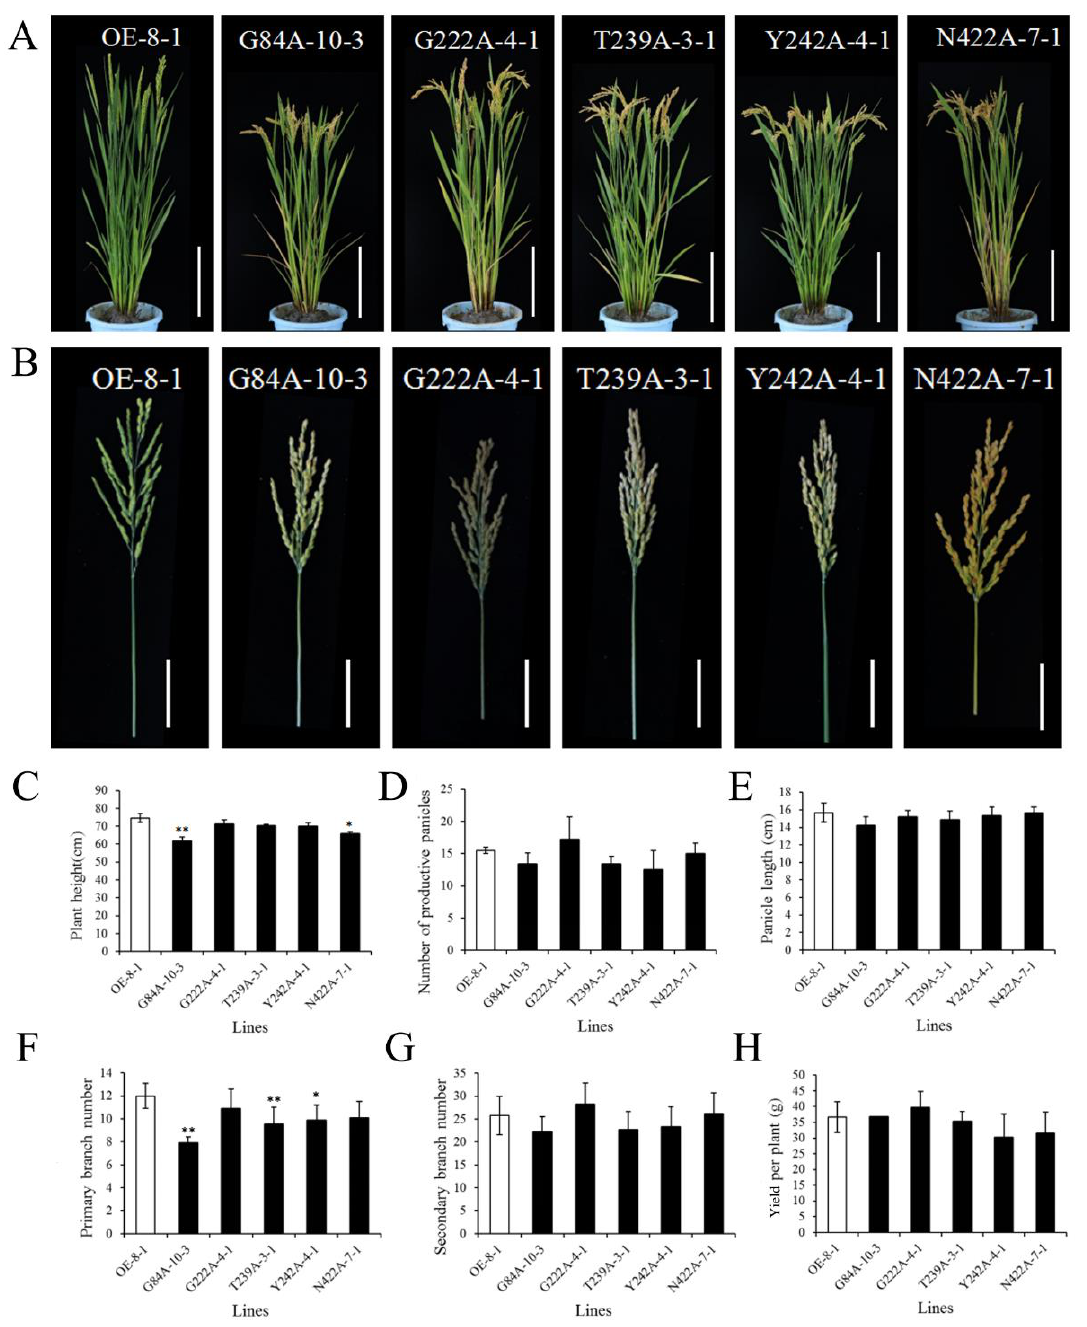
Figure 7. Phenotypes of Cmphts -OE T2 lines at the reproductive stage. ( A ): Plant architecture of CmPT2 -OE-8-1 and Cmphts -OE lines at the reproductive stage. Bar = 20 cm. ( B ): Mature panicles of CmPT2 -OE-8-1 and Cmphts -OE lines. Bar = 5 cm. ( C – H ): Comparisons between CmPT2 -OE-8-1 and Cmphts -OE lines at the reproductive stage for average plant height ( C ), number of productive panicles ( D ), panicle length ( E ), number of primary branches ( F ), number of secondary branches ( G ), and yield per plant ( H ). Values are given as the mean ± SD. “**” and “*” indicates a significant difference at the 0.01 and 0.05 level, respectively.